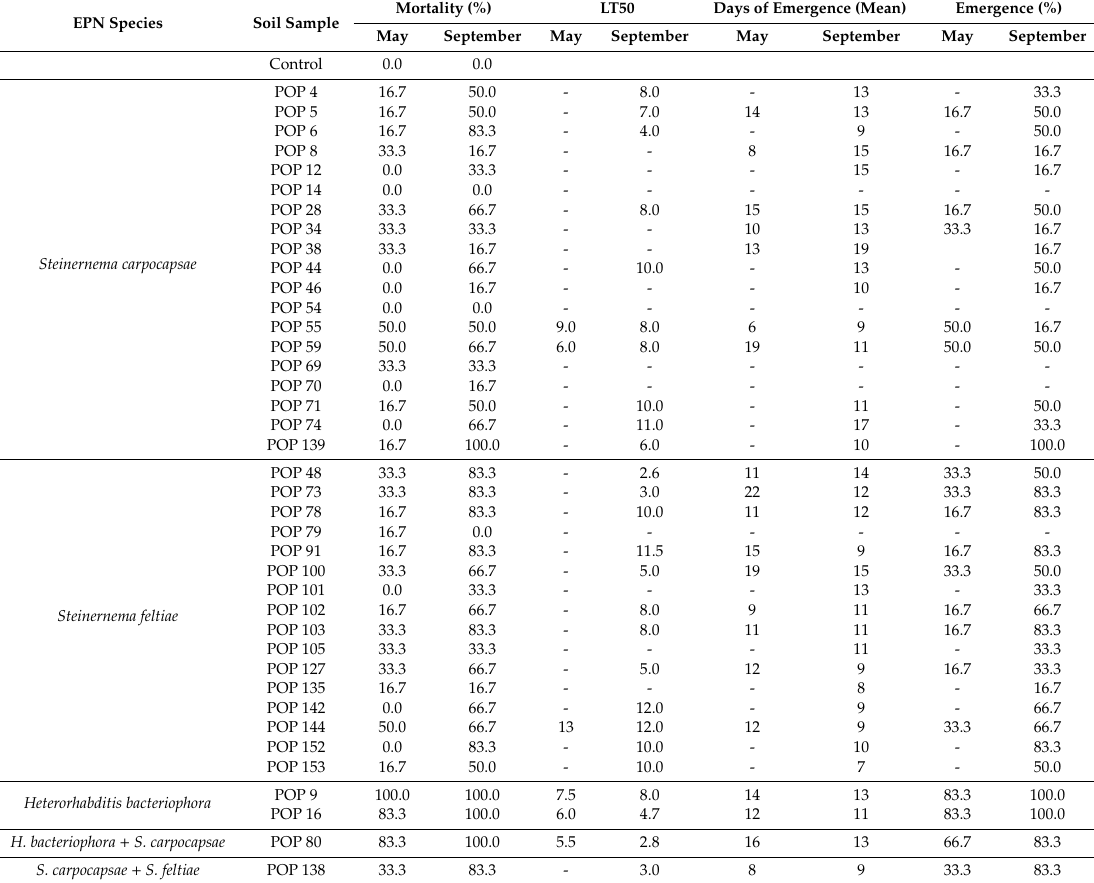
Table 2. Results of laboratory assays. Percentage of mortality, lethal times to 50% (LT50), and days and percentage of infective juveniles (IJs) emergence of all isolates against Popillia japonica larvae in pre- (May) and post-wintering (September)